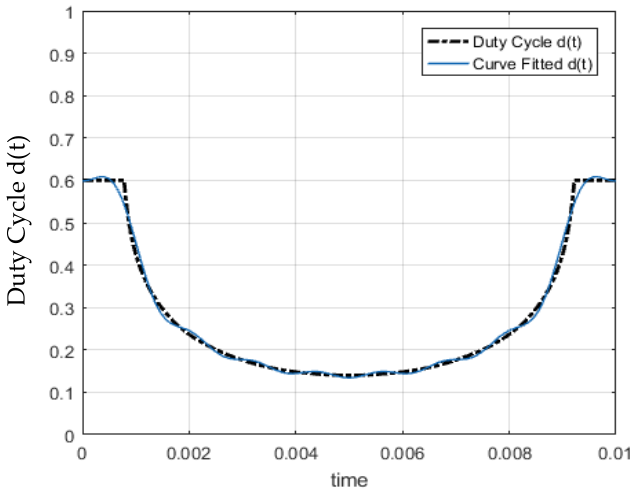
Figure 10. Duty cycle curve fitting.